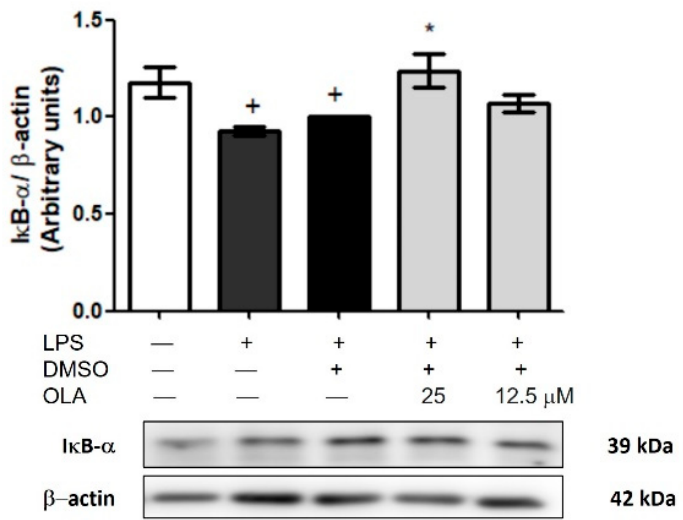
Figure 9. OLA pretreatment decreased I κ B- α degradation in murine peritoneal isolated macrophages. Cells were pretreated with OLA (25 and 12.5 µ M) and incubated in presence or absence of LPS for 18 h. Densitometry was performed following normalization to the control ( β -actin housekeeping gene). Data are shown as means ± SEM ( n = 6). + p < 0.05 vs. control cells (no stimulated); * p < 0.05 vs. LPS − DMSO-treated cells.